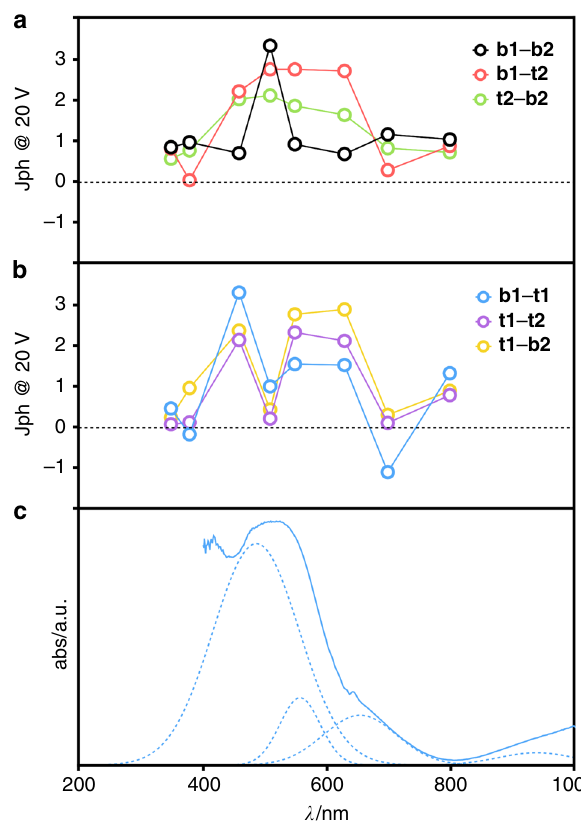
Fig. 8 Comparison of photoresponse intensities at 20 V with the deconvoluted absorption spectrum of MOF-CoNDI-py-2. a , b Photoresponse intensities at 20 V. c Electronic absorpotion spectrum of